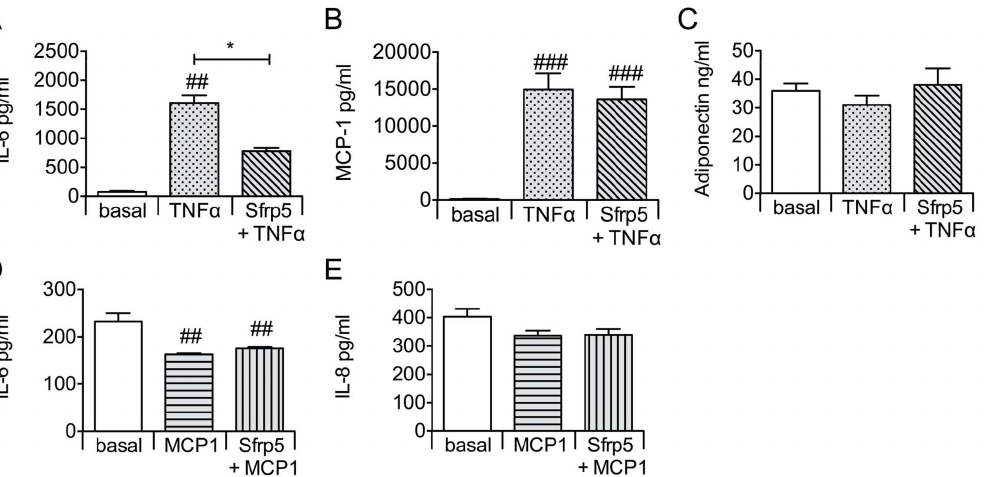
Figure 2. Effect of Sfrp5 on adipokine and myokine release from cytokine-stimulated cells. Primary human adipocytes (A–C) and primary human skeletal muscle cells (D–E) were exposed to Sfrp5 (4 h; 100 ng/ml) prior to incubation with TNF a (24 h; 5 nmol/l) or MCP-1 (18 h; 2 ng/ml). Cytokine release by the adipocytes and myotubes was quantified by ELISA, and expressed as mean 6 standard error of the mean (A–C: n=5; D–E: n=4). Differences among the various conditions were analyzed by Friedman’s test followed by Dunn’s multiple comparison test; ### indicates P , 0.001; ## , P , 0.01 versus cells kept untreated (basal); *, P , 0.05 for the effect of the additional Sfrp5 incubation versus TNF a alone.